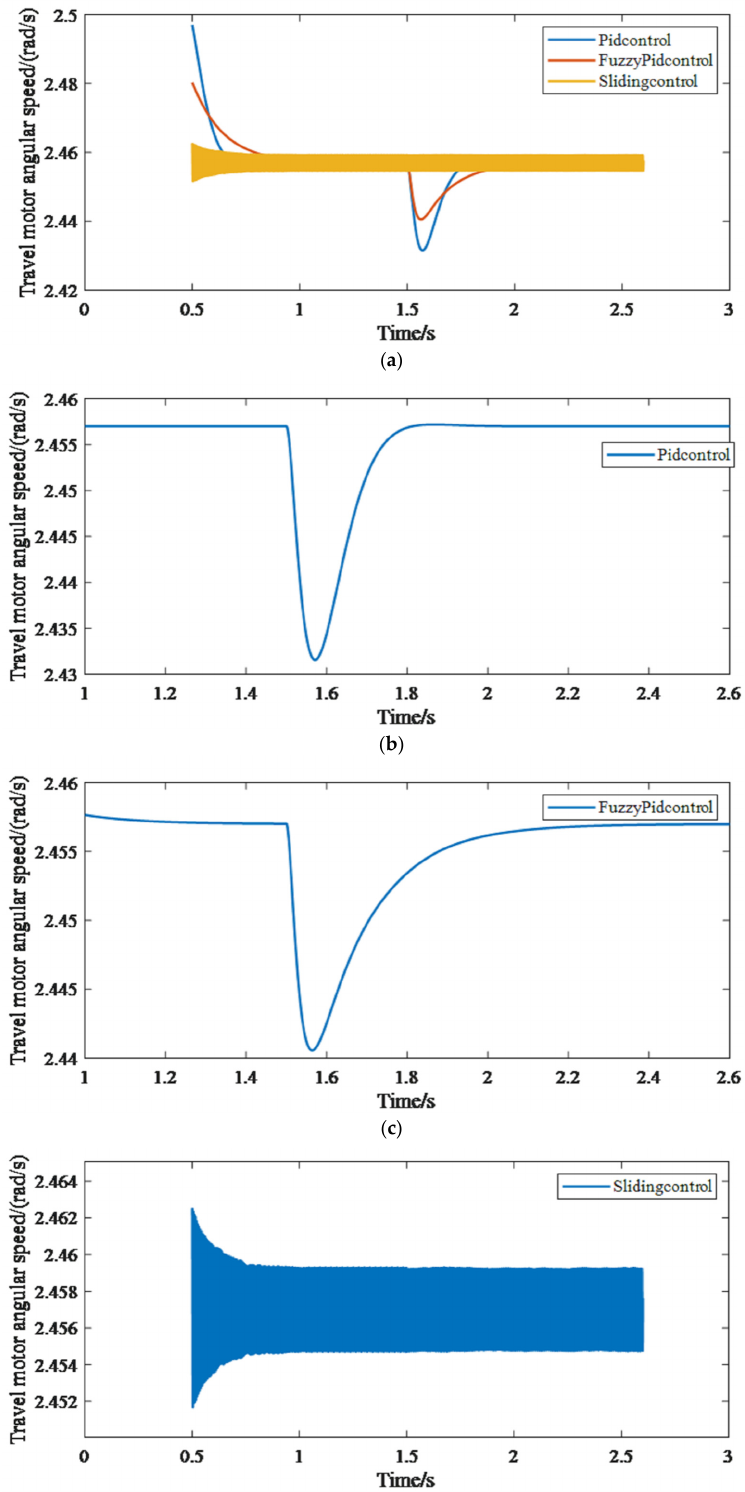
Figure 14. ( a ) Simulation results of sudden climbing under smooth conditions of the travel drive system with three control strategies. ( b ) Simulation result of sudden climbing under smooth conditions of the travel drive system with PID control strategy. ( c ) Simulation result of sudden climbing under smooth conditions of the travel drive system with adaptive fuzzy PID control strategy. ( d ) Simulation result of sudden climbing under smooth conditions of the travel drive system with sliding mode control strategy. (3) The situation 2 of a sudden increase in load when the travel motor was in a smooth control state: sudden crossing of a bump of the harvester in a smooth running state. The simula- tion results of the harvester suddenly crossing a bump in a smooth state were as follows: the travel motor reached a smooth running state before 2.0 s , and at 2.0 s , a sudden ditch obstruction appeared on the monopoly surface (bed surface). Assuming that the load on the travel motor increased by 61.1% at this time, which was an oversized disturbance sit- uation, the simulation results are shown in Figure 15a–d. The travel drive system moved from its original smooth running state to a gully obstruction and finally backed to a stable state again. The steady-state transition time of the travel drive system under the PID con- trol strategy was 0.3092 s with a maximum deviation from the set speed of 0.0382 rad/s . The steady-state transition time of the system under the adaptive fuzzy PID control strat- egy was 0.9621 s with a maximum deviation from the set speed of 0.0247 rad/s . The steady- state transition time was 0.0027 s and the maximum deviation from the set speed was 0.0023 rad/s under the sliding mode control strategy. ( a )